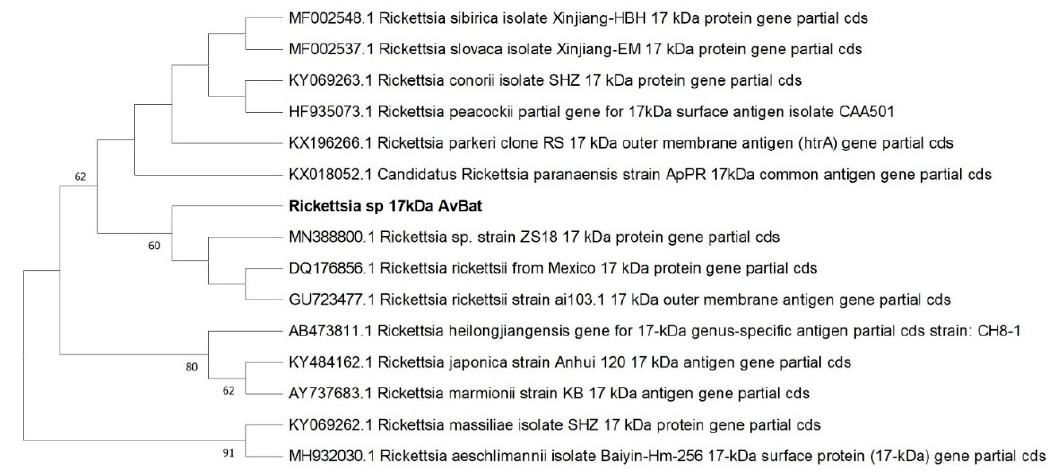
Figure 2. Phylogenetic tree based on 17 kDa gene sequences of Rickettsia species, constructed by maximum likelihood using Kimura 2-parameter and complete deletion. Sequences detected in our study (‘ Rickettsia sp. AvBat 17 kDa’ n = 32) are highlighted in bold. The reliability of the tree was tested by 500 bootstrap replicate analyses; only values greater than 50% are shown. Table 4. Number of specimens with successful amplification of Rickettsia gene targets by conven- tional PCR assays. The sequences obtained from the amplification of the 17 kDa and gltA (I) genes have been used for phylogenetic assays. Gene